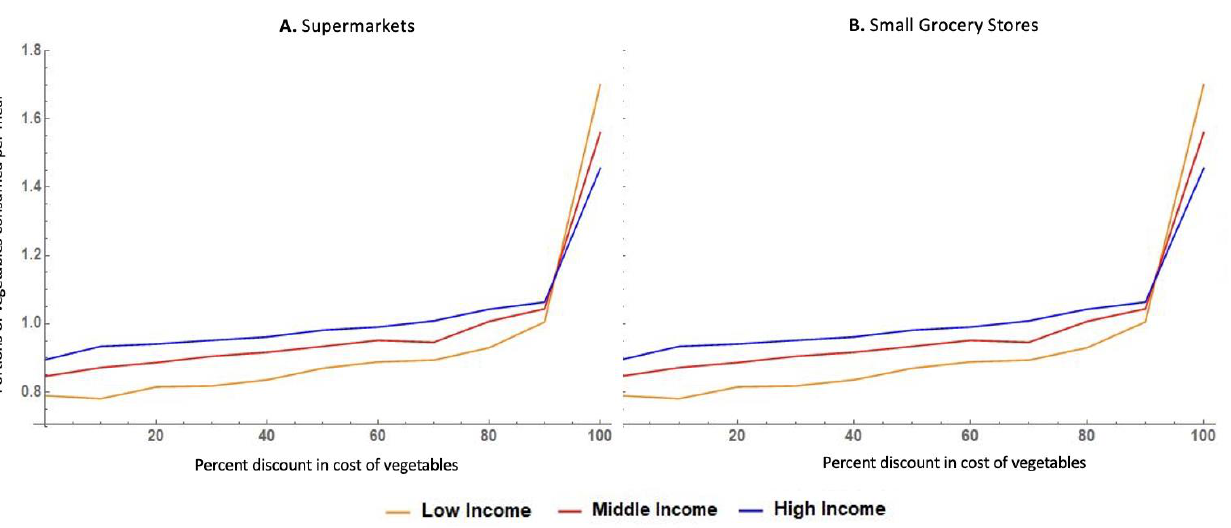
Figure 5. Agent-based model simulation results for expanded economic access to vegetables via small grocers and supermarkets scenario.